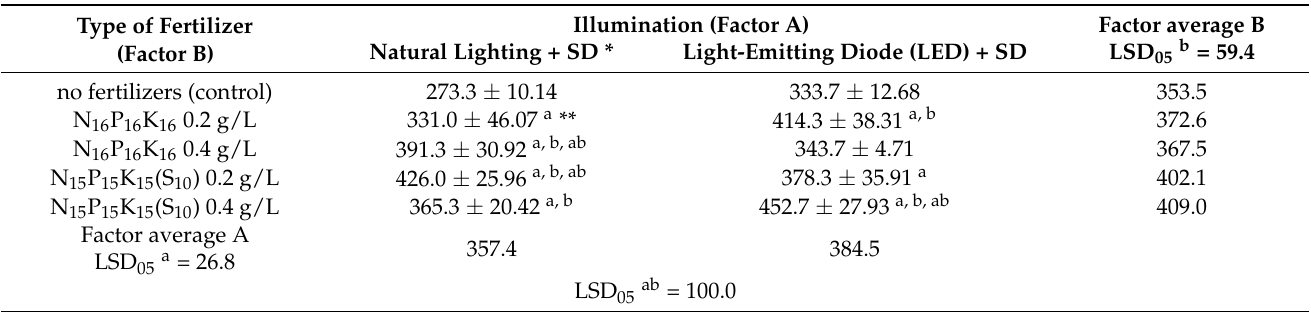
Table 5. Indices of chlorophyll content in the leaves in highbush blueberry ( Vaccinium corymbosum L.) cv. Brigitta Blue on the 56th day of growing completion.